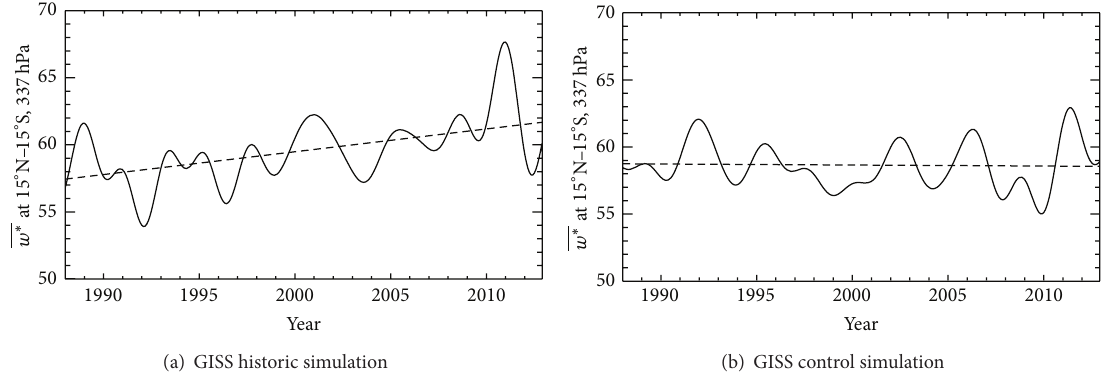
Figure 6: (a) Residual vertical velocity ( 𝑤 ∗ ) averaged over 15 ∘ N–15 ∘ S at 337 hPa from historic simulation (solid line) and trend (dashed line). (b) Same as (a) except for control